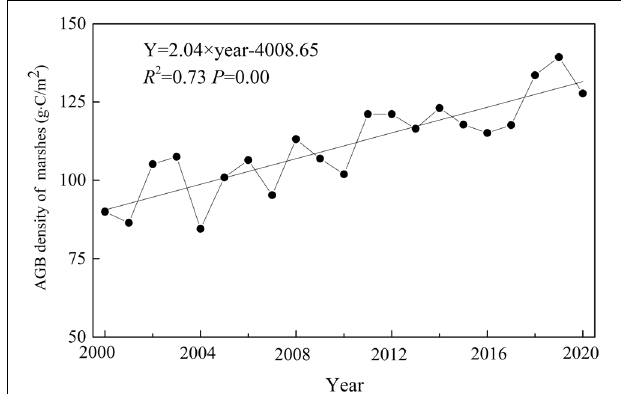
FIGURE 3 | Temporal variation of aboveground biomass density on the western Songnen Plain marshes from 2000 to